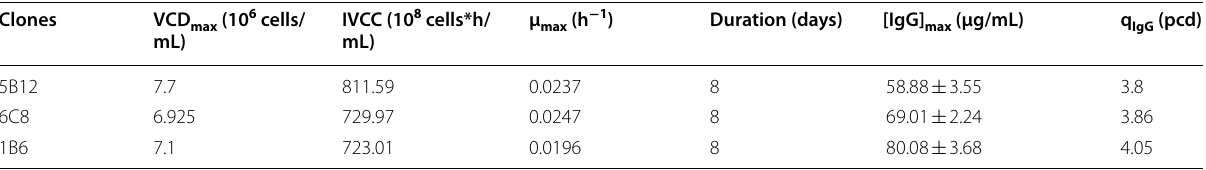
Table 1 Productivity and growth characteristics of selected trastuzumab-expressing CHO-K1 clones in batch culture (chemically defined, protein-free medium and shaking